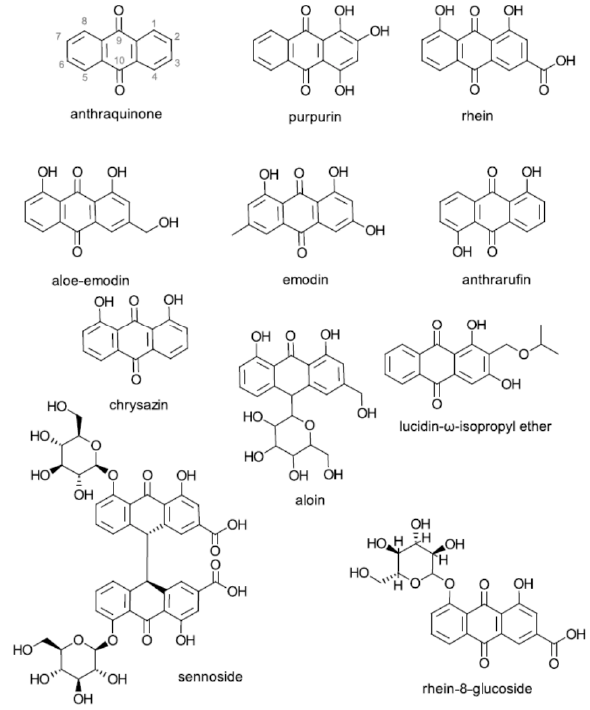
Figure 1. Chemical structures of anthraquinone and derivatives.